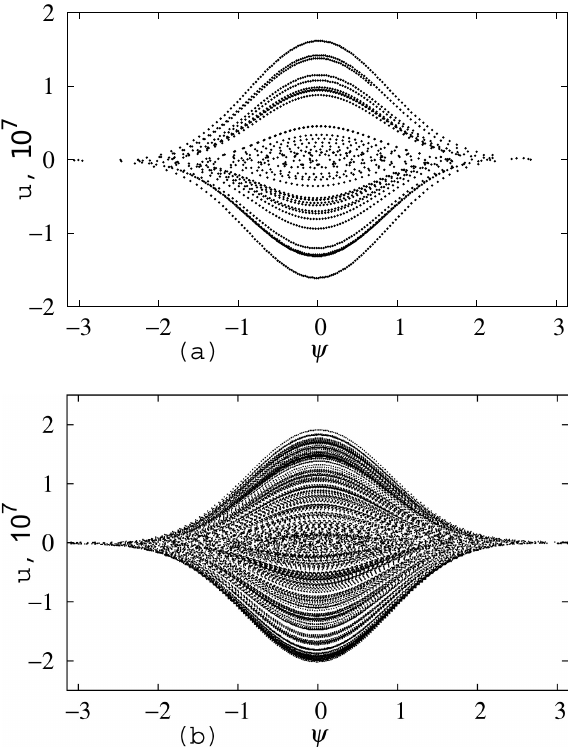
Fig. 5. Intermittent chaotic behavior of map (62) with Q = 5 × 10 5 . (a) t = 2 × 10 3 and (b) t = 2 · 10 4 iterations of a single initial con-